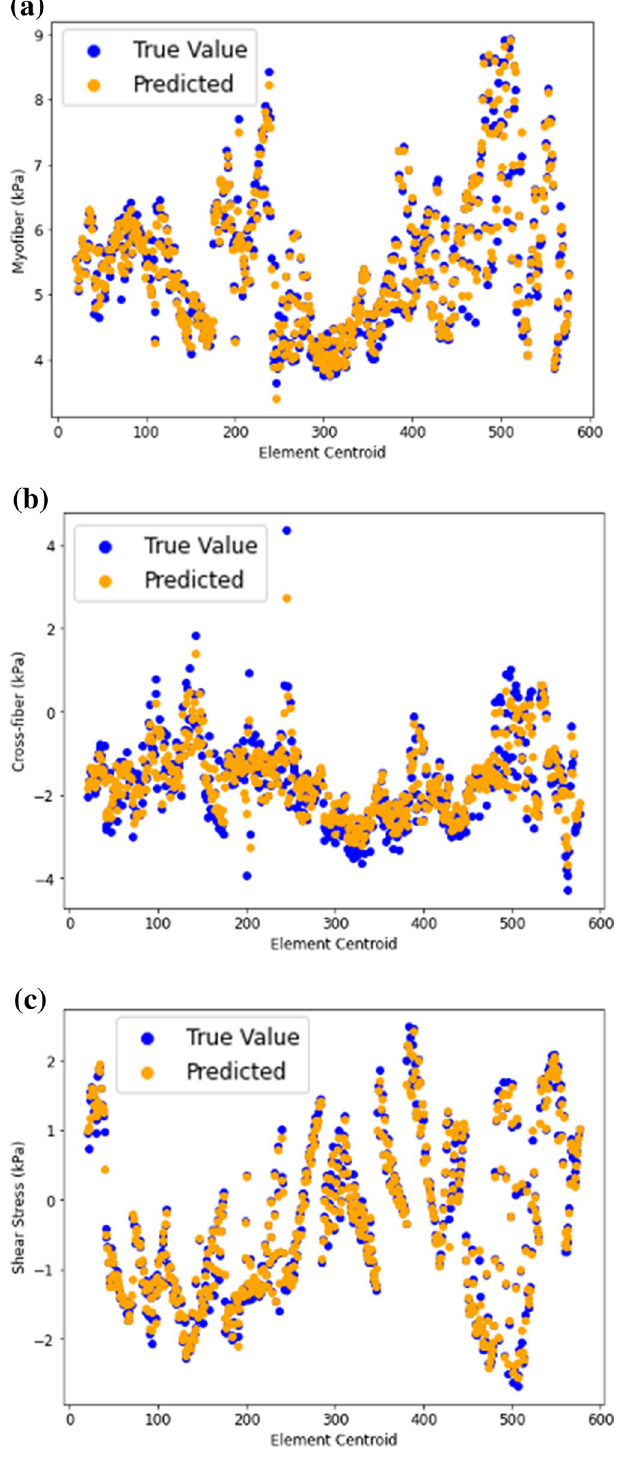
Figure 7. Endocardial ( a ) myofiber stress, ( b ) cross-fiber stress and ( c ) shear stresses predicted using RNN with LSTM. Each FE model was assumed as a sequence of previous FE model. Moreover, at each element centroid data from 20 previous elements were